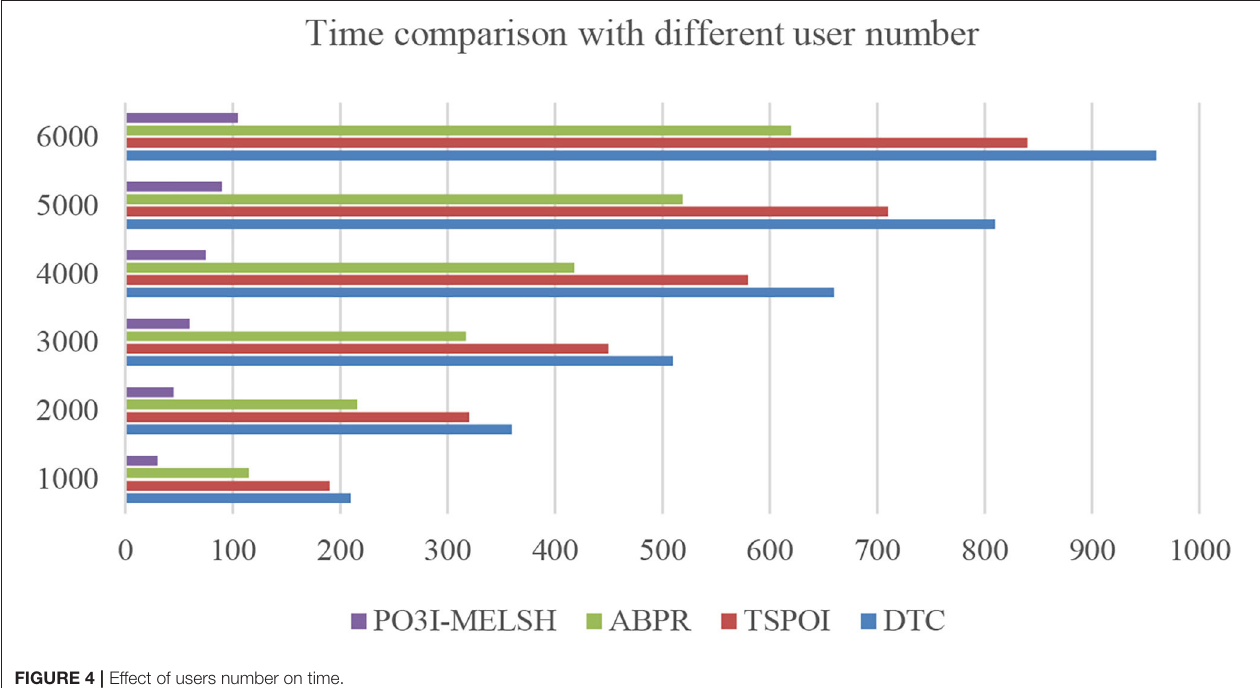
FIGURE 4 | Effect of users number on time.